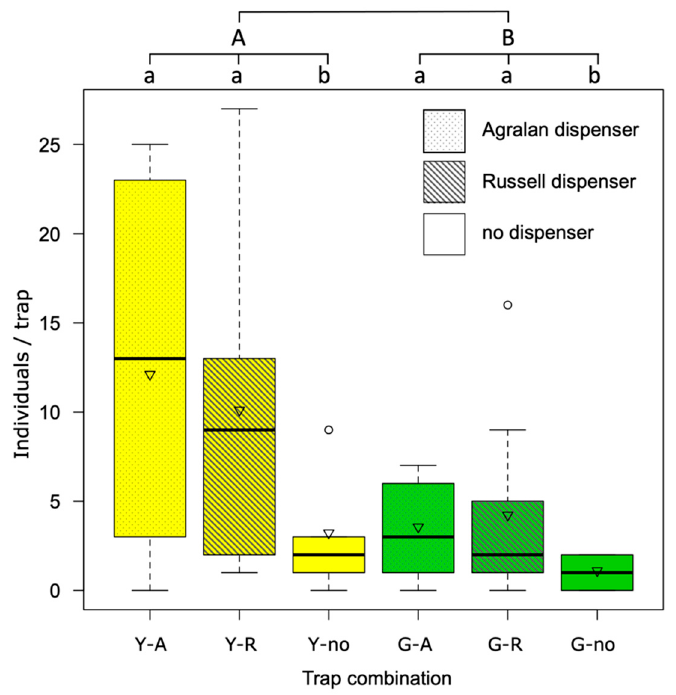
Figure 6. Catches of SBW adults on the yellow (Y) or green (G) sticky traps baited or not with two types of dispensers (A= Agralan, R= Russell, no= no dispenser). The boxes enclose the first and third quartiles; the ends of the whiskers represent the 5th/95th percentiles, the solid lines the median and the triangle the mean. Different lowercase letters indicate statistically significant differences between dispensers, while uppercase letters indicate statistically significant differences between colors (Tukey’s test following ANOVA, p < 0.05).